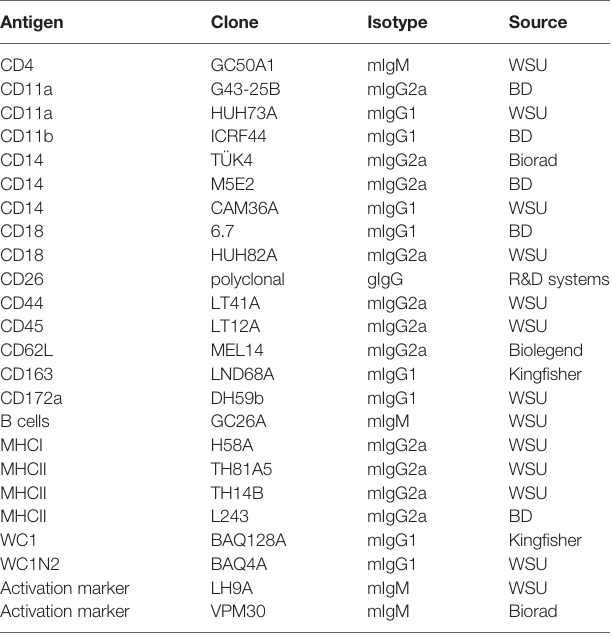
TABLE 1 | Camel leukocyte antigen cross-reactive monoclonal